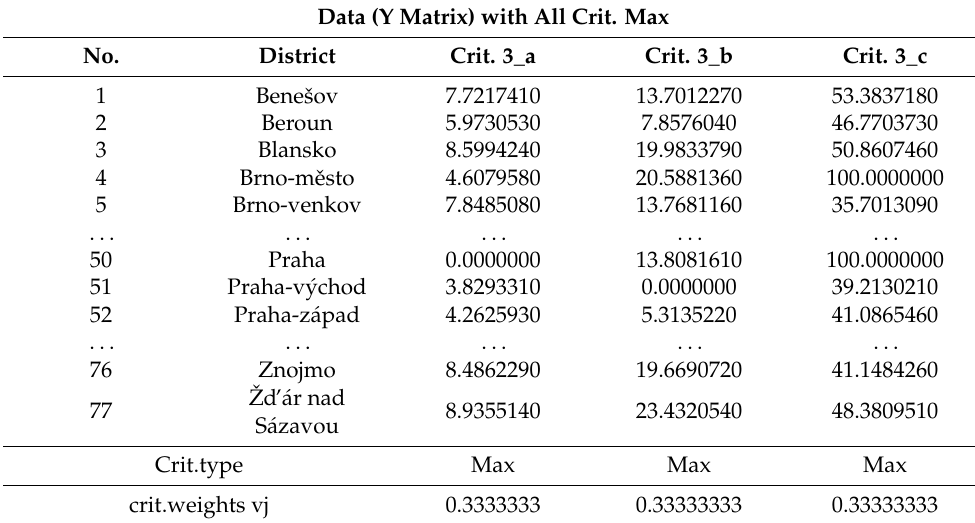
Table A5. Data for 3. Area—selected districts—change into max. criteria. Data (Y Matrix) with All Crit. Max